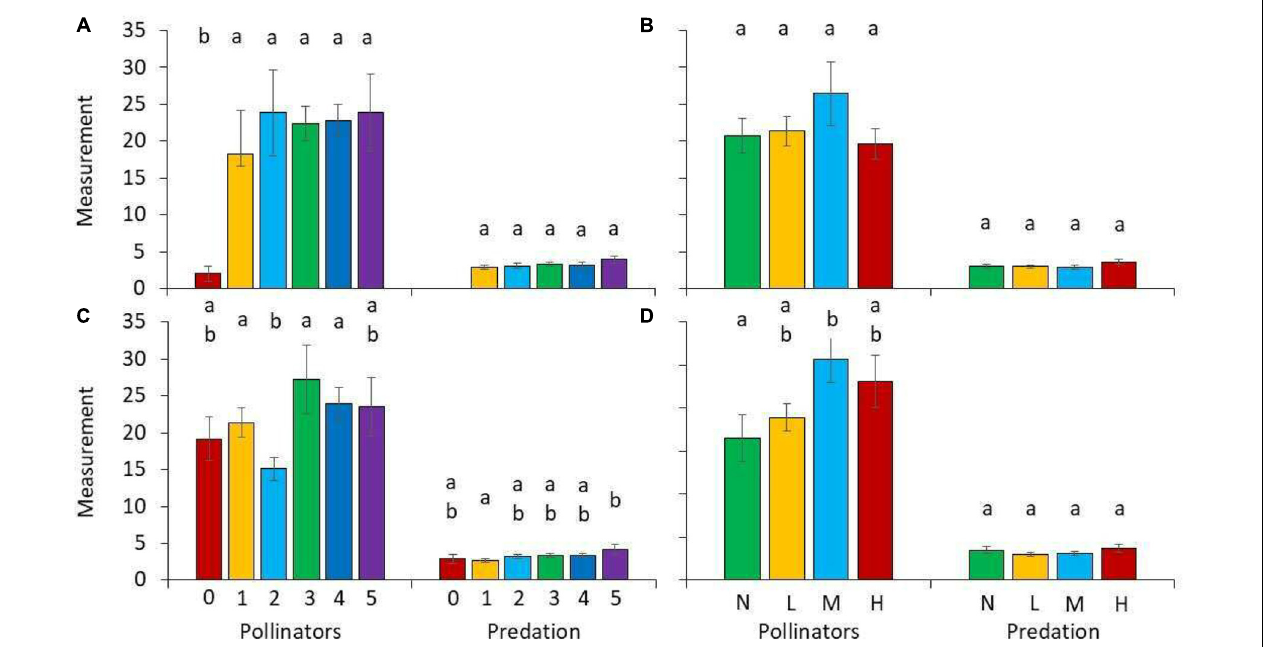
FIGURE 4 | Average numbers of pollinator activity (all color traps combined) and arthropod predation (bite marks) in dependence on the fraction of (A) herb cover, (B) leaf litter, (C) shrub cover (0: 0%, 1: 1–24%, 2: 25–49%, 3: 50–74%, 4: 75–99%, and 5: 100%), and (D) number of blossoms ( n one, l ow, m edium, h igh). Different letters above the bars denote statistically significant differences in pair-wise U-tests after one-way Kruskal–Wallis ANOVA at P < 0.05. Error bars denote standard errors.